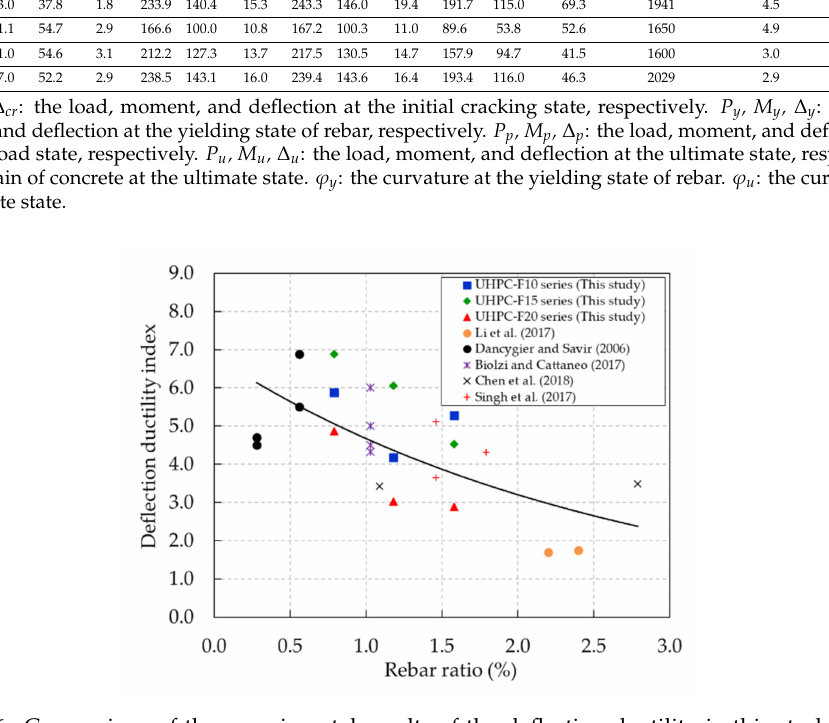
Figure 16. Comparison of the experimental results of the deflection ductility in this study and in previous